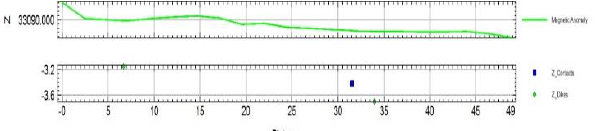
Figure 17: Total magnetic intensity profile for traverse 3 location1.